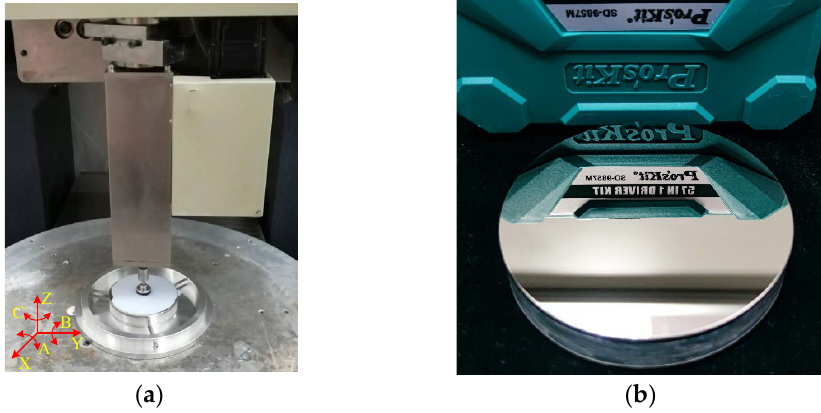
Figure 13. Φ100 mm mirror ( a ) smoothing polishing, and ( b ) finished mirror. The surface roughness of the NiP coating was measured by atomic force microscope (Dimension Icon, Bruker, Rheinstetten of Germany) after six times of smoothing polishing. The results are shown in Figure 14, the surface roughness of the NiP coating reached RMS 0.223 nm.